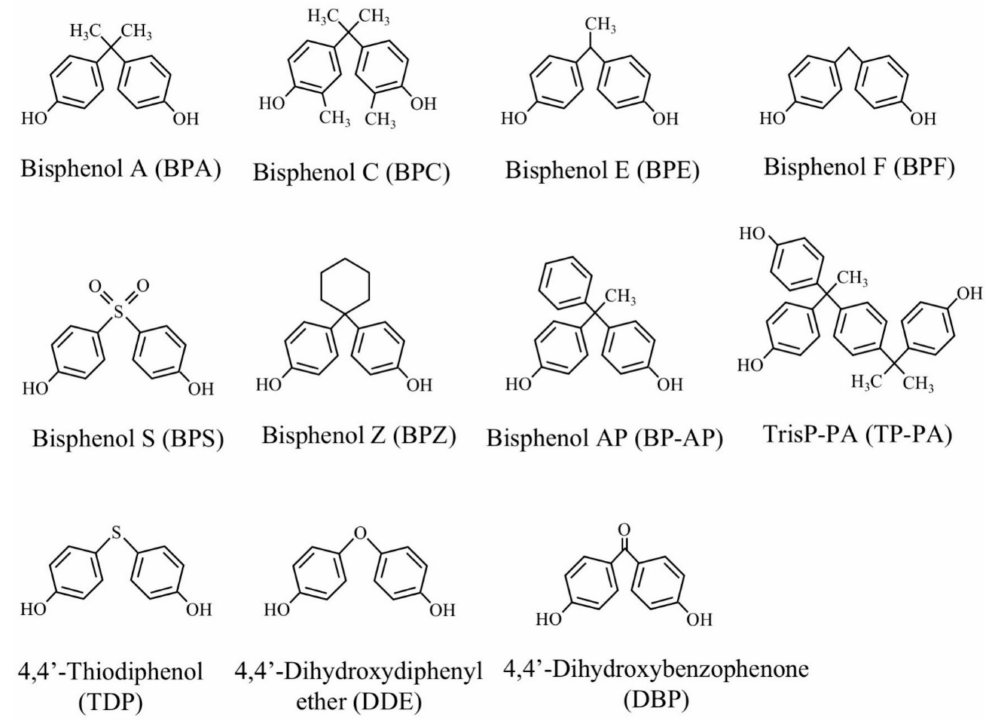
Figure 2. Structures of bisphenols and their structural analogs